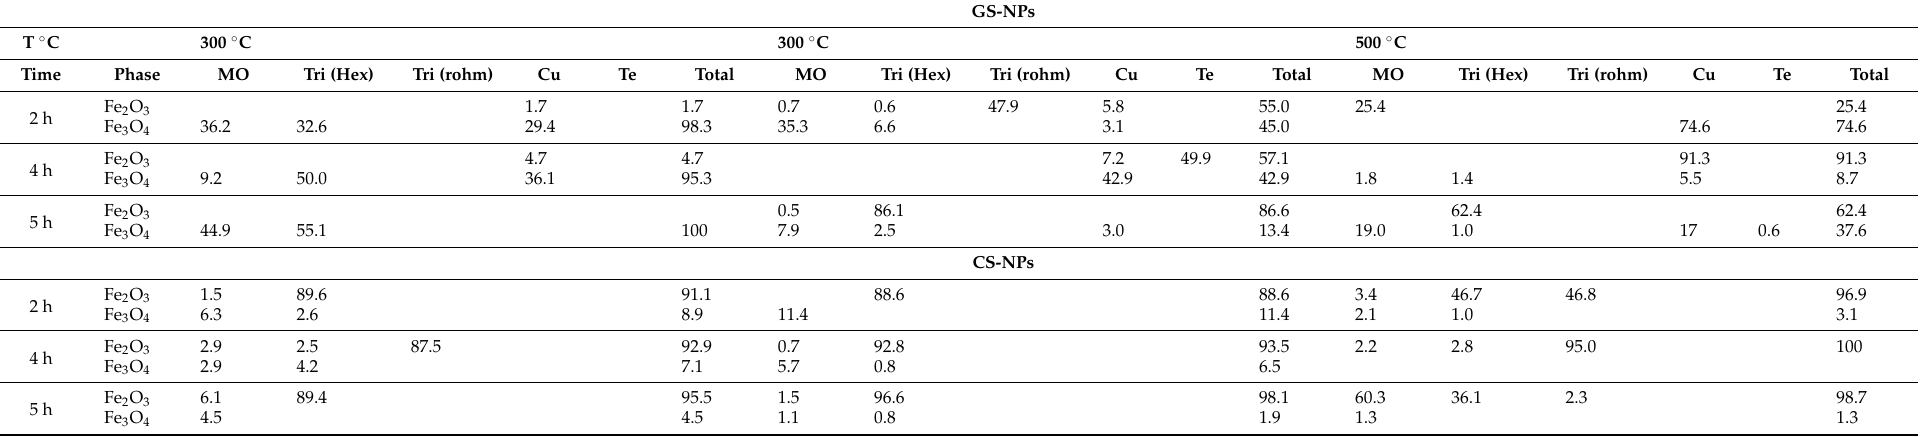
Note: Different superscript letters (a–f) within a row indicate significant differences among mean observations ( p < 0.05). Table 2. Results obtained for different parameters of GS-NPs using PDL extract and the CS-NPs using the chemical method at different temperatures (200, 300, and 500 ◦ C) and times (2, 4, and 5 h): Crystal systems attributed to hematite (Fe 2 O 3 ) and magnetite (Fe 3 O 4 ) proportions; Mo: Monoclinic; Tri (hex): Trigonal (hexagonal axis); Tri (rohm): trigonal (rhombohedral axis); Cu: Cubic; Te: